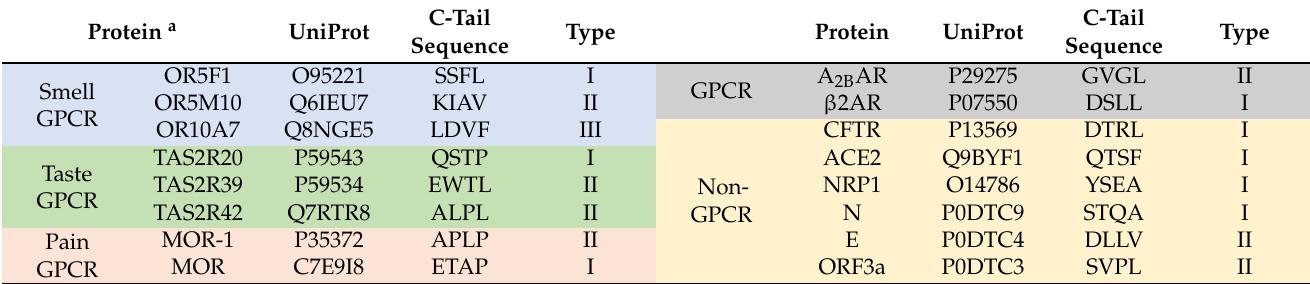
Table 1. GPCRs and non-GPCRs containing various PDZ binding